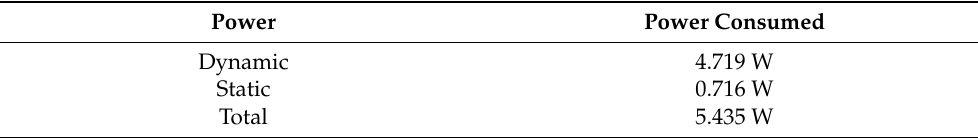
Table 5. Power Consumption of the FPGA